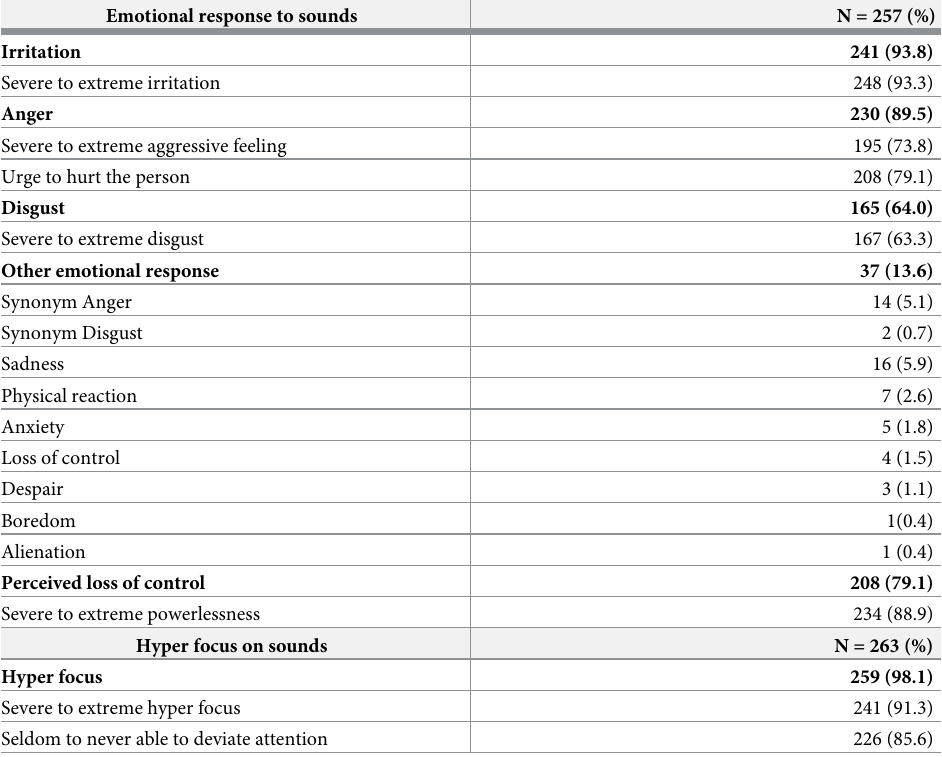
Table 3. Emotional response and hyper focus to sounds in misophonia subjects. Emotional response to